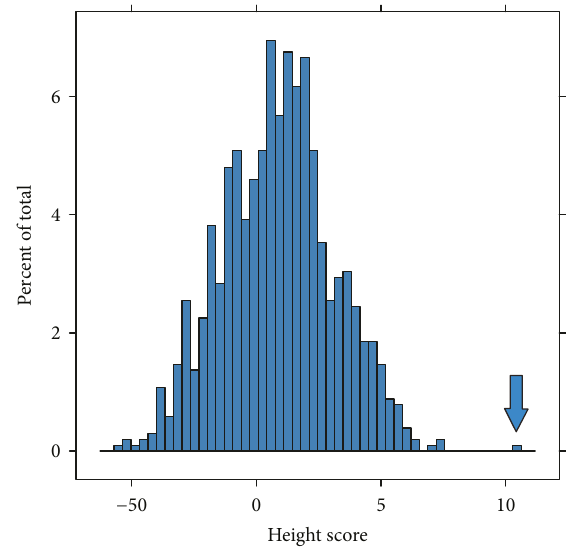
Figure 2: Height score distribution calculated using the 2910 SNPs. Mr. Bradley ’ s height score (10.32, indicated by the arrow) ranked highest when compared to the 1020 individuals from ADNI and Cache County, while the next highest was 7.43. The mean height score within the ADNI and Cache County data was 0.98 with a standard deviation of 2.22, making Mr. Bradley ’ s height score 4.2 standard deviations above the Table 1: Mr. Bradley ’ s height score percentiles when compared to the population data for random subsets of SNPs.